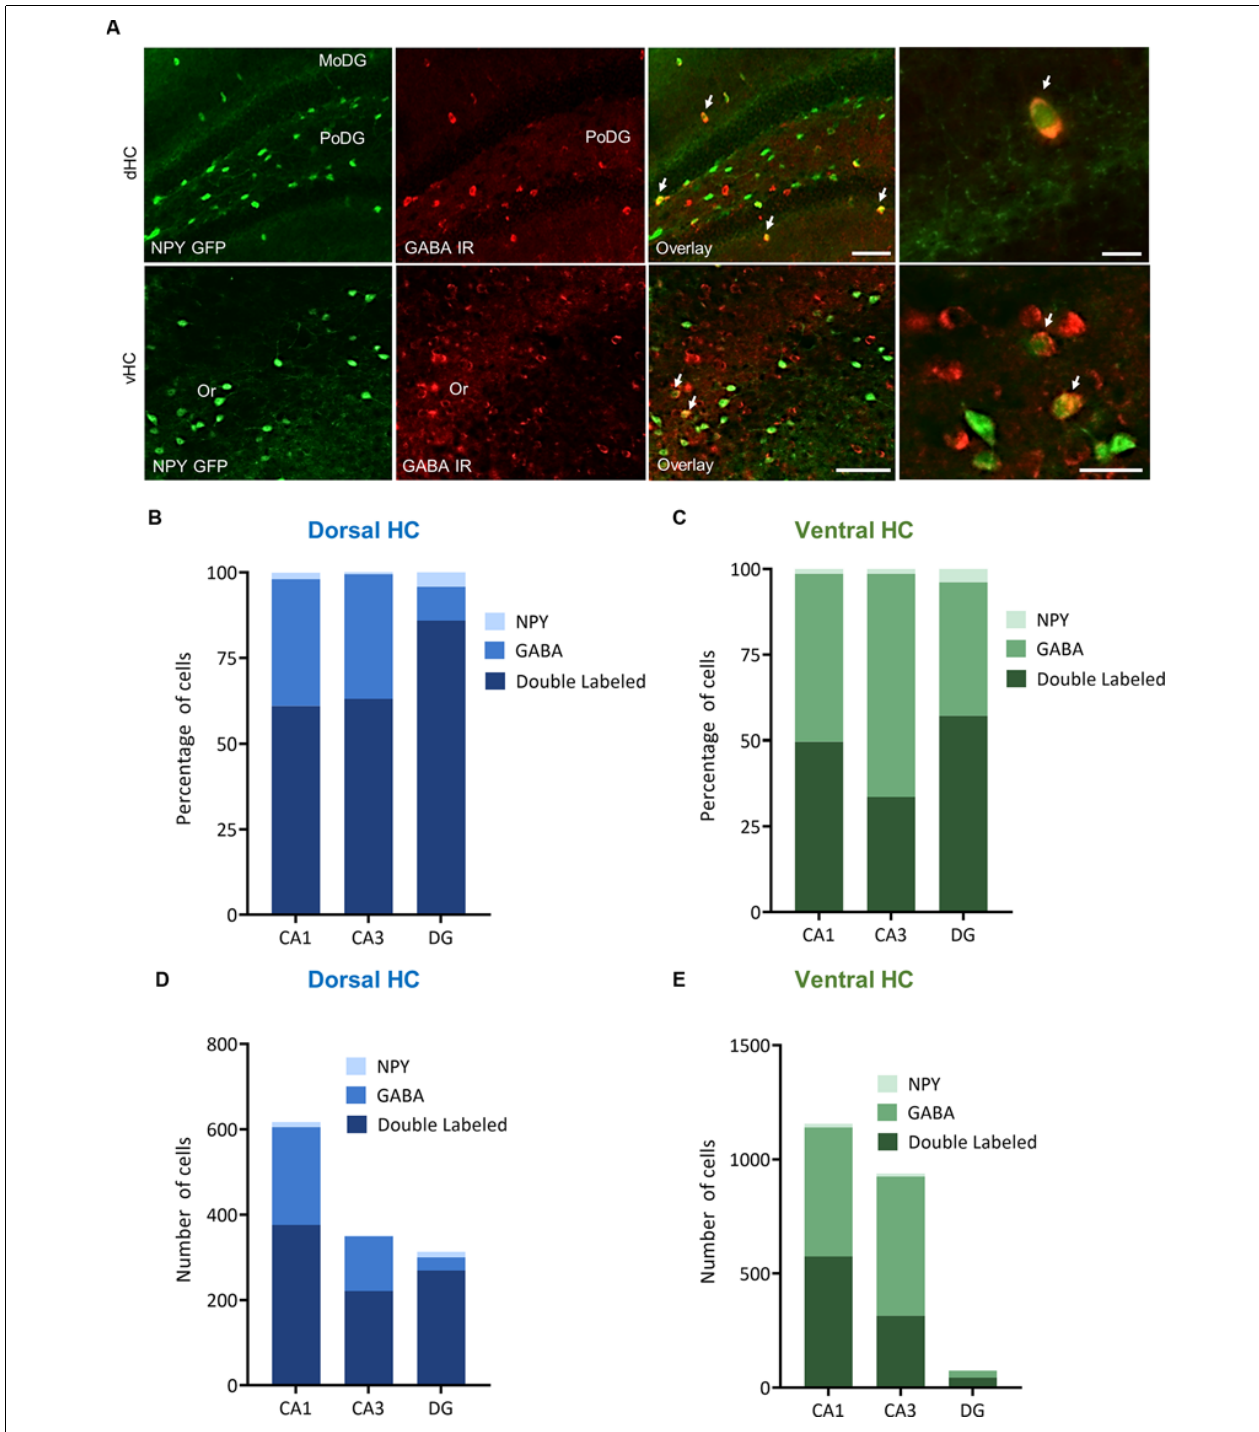
FIGURE 5 | Distribution and quantification of co-expression of GABA with NPY in the dorsal (dHC) and ventral (vHC) mouse hippocampus. (A) Dual immunohistochemistry for GABA and NPY-GFP auto-fluorescence in the dorsal (dHC) and ventral hippocampus (vHC) of NPY-GFP mice. Cells in green indicate NPY-GFP + neurons and cells in red indicate GABA expressing neurons. (B) Histograms showing the percentage of NPY-GFP neurons in CA1, CA3, and DG of the dorsal hippocampus that are co-labeling with GABA. (C) Histograms showing the percentage of NPY-GFP neurons in CA1, CA3, and DG of the ventral hippocampus that are co-labeling with GABA. Note that NPY neurons are exclusively GABAergic. (D) Number of NPY-GFP and GABA neurons in CA1, CA3, and DG of the dorsal and (E) ventral hippocampus. Scale bars: lower magnification 200 µ m (third column), higher magnification 50 µ m (last column). Abbreviations: MoDG, molecular layer of the dentate gyrus; PoDG, hilus/polymorph layer of the dentate gyrus; Or, stratum oriens.